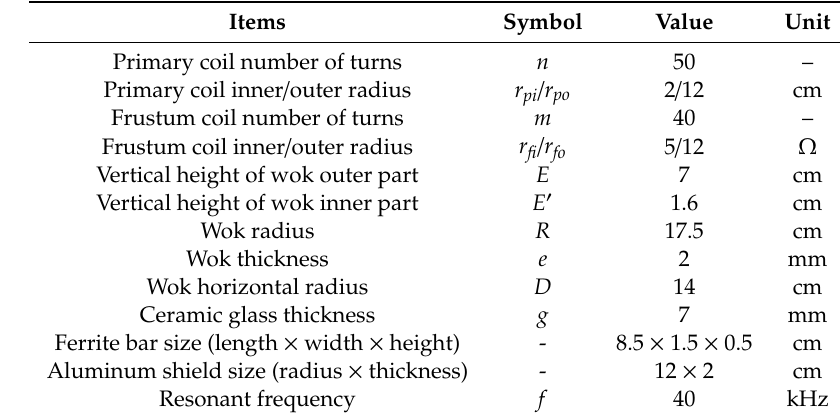
Figure 4. Geometry model of the proposed system. Table 2. Key parameters of the wok geometry model.